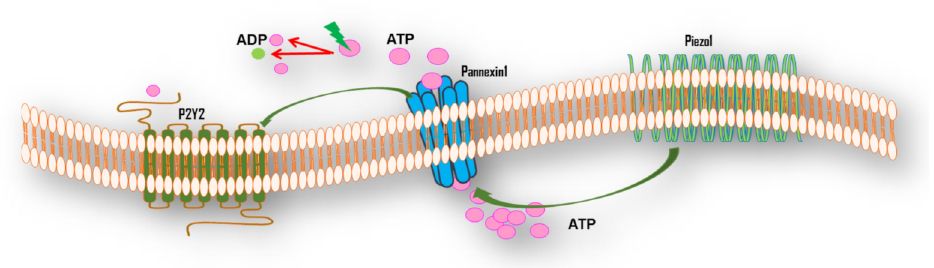
Figure 3. Endothelial P2Y2 interactions with Pannexin1 and Piezo1 under fluid shear stress conditions in systemic circulation. Fluid shear stress activates Piezo1, a mechanosensitive channel that mediates ATP release via pannexin1 channels. Ectonucleotidases hydrolyze the extracellular nucleotide ATP to ADP, AMP, and adenosine, which activate P2Y2 and other P2Y receptors, suggesting P2Y2 as